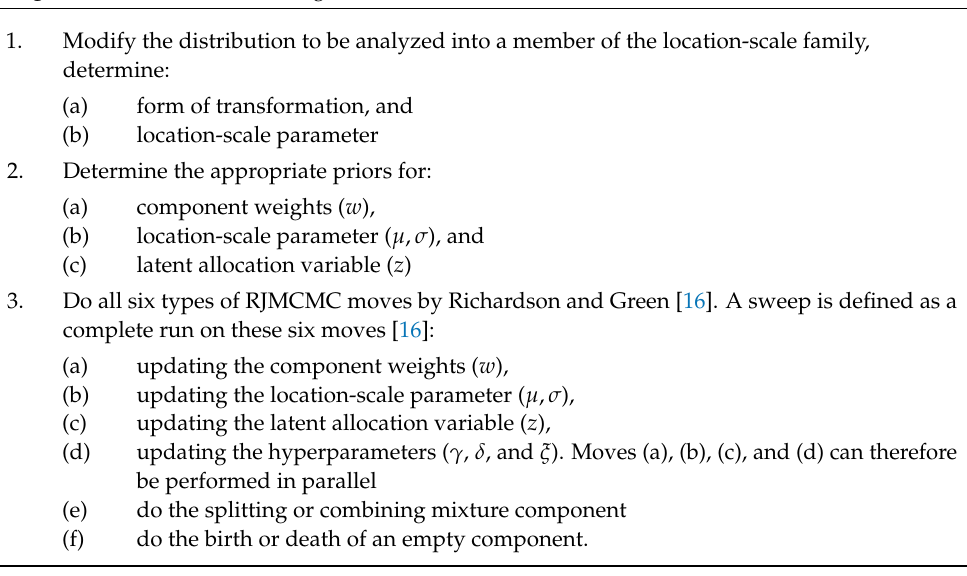
Algorithm 1. NG-RJMCMC